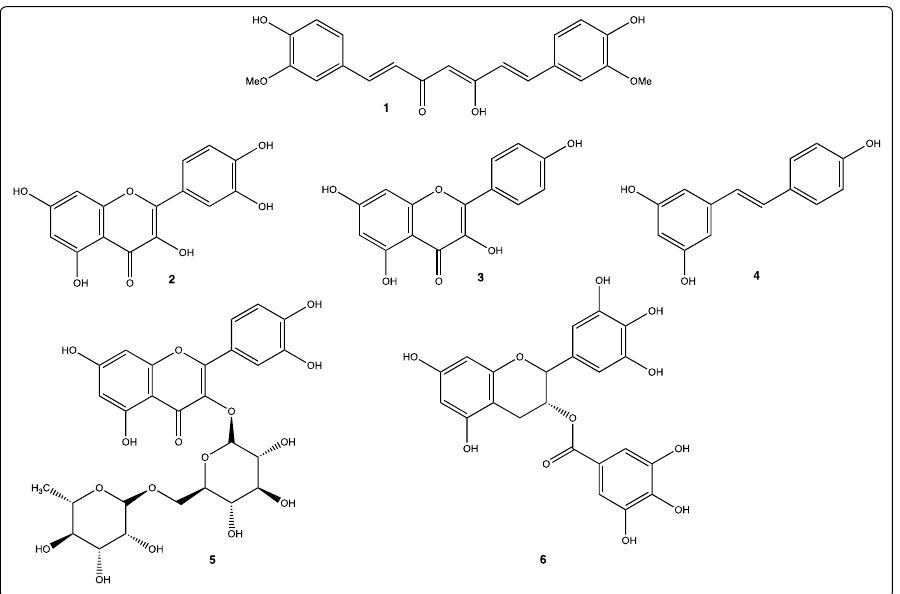
Figure 2. Chemical structures of selected polyphenols: 1: curcumin; 2: quercetin; 3: apigenin; 4: resveratrol; 5: Rutin; 6: EGCG.